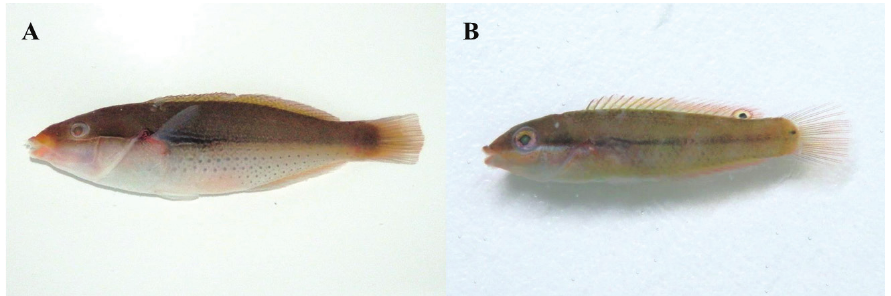
Figure 8. A Goniistius zonatus , MFD-663, 55.6 mm SL B Abudefduf sexfasciatus , MFD-845, 33.7 mm SL.